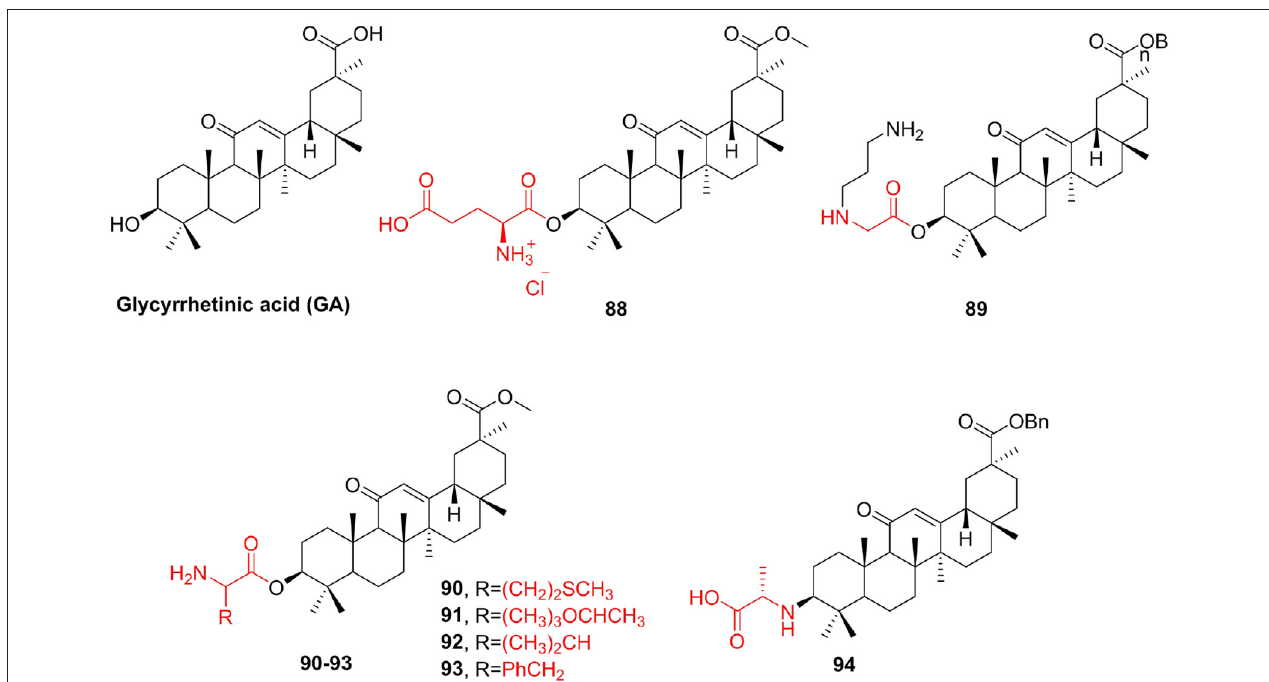
FIGURE 11 | Glycyrrhetinic acid